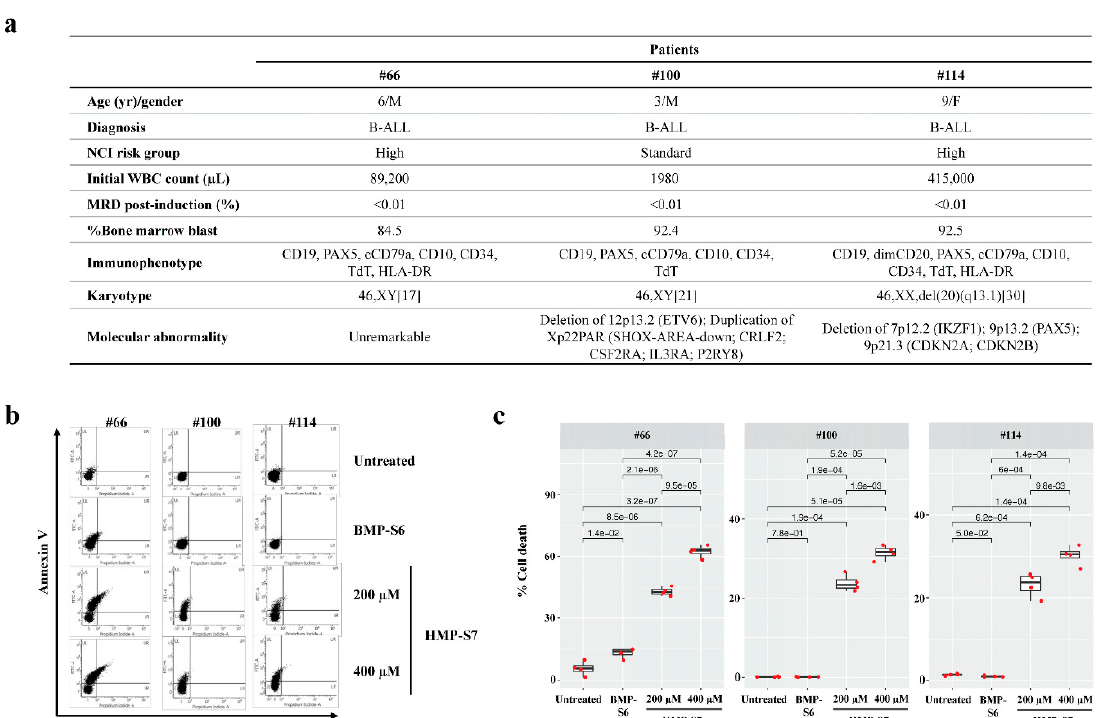
and necrosis) of flow cytometric data. * p < 0.05, ** p < 0.01 compared to untreated condition. All